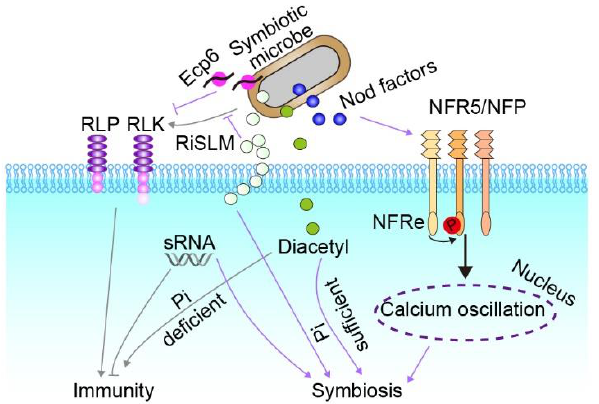
Figure 2. Signaling pathways employed by microbes to evade plant immunity and establish symbiosis. Beneficial microbes establish symbiotic interactions by secreting effectors that interfere with plant immune systems. Nod factors, detected by NFR5/NFP, trigger calcium oscillations in the nucleus and promote symbiosis. Recently, a new LysM receptor, NFRe, has been identified and guarantees robust symbiotic signaling through phosphorylating NFR5. Furthermore, RiSLM, a lysin motif effector, suppresses recognition of microbes by plants by protecting the cell walls from chitinases. Similarly, the Ecp6 protein, which contains the LysM domain, competes with plant chitin receptors for ligand binding to prevent host immune activation. Moreover, sRNAs from microbes have been found to impact the host immune system and help establish symbiosis. In addition, microbial diacetyl modulates the transition from immunity to symbiosis in a phosphate-dependent manner.